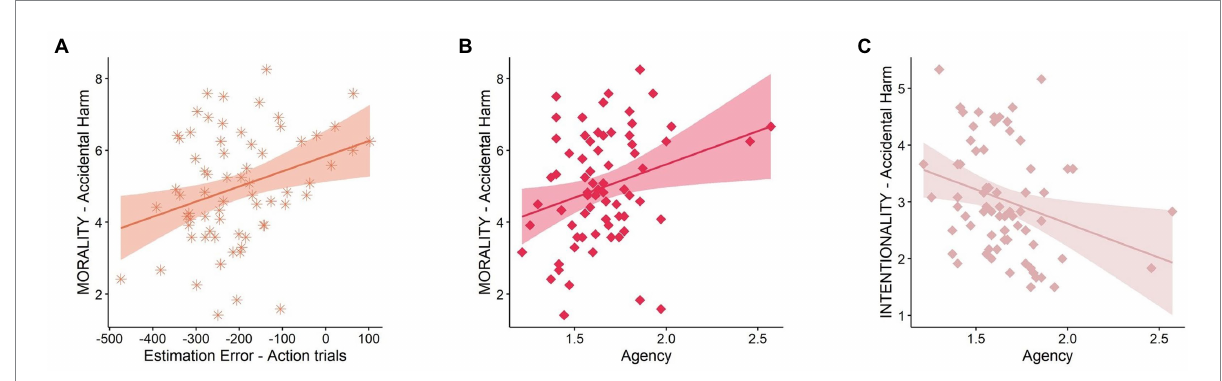
FIGURE 3 Correlation Analysis Results. (A) Scatter plot showing the correlation between moral permissibility ratings of Accidental Harm scenarios (y-axis) and the estimation error averaged across all the time intervals in Action trials only (x-axis). (B) Scatter plot showing the correlation between moral permissibility ratings of Accidental Harm scenarios (y-axis) and Explicit Agency (x-axis). (C) Scatter plot showing the correlation between malicious intentionality ratings of Accidental Harm scenarios (y-axis) and Explicit Agency